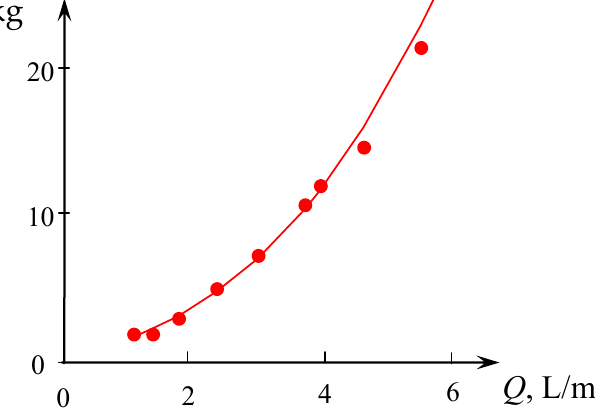
2 732 0 207 . . Q ( Q is in L/min, ε is in